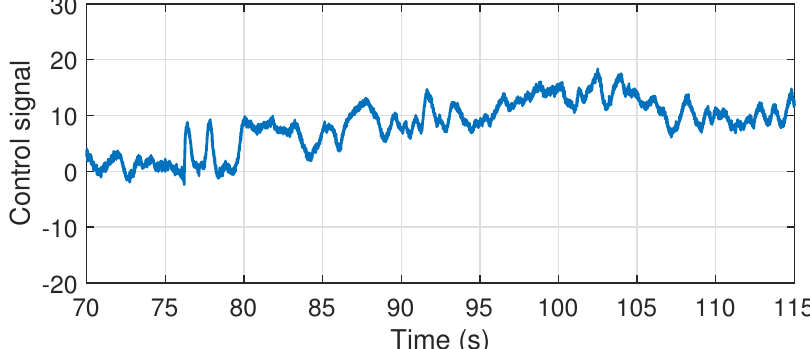
Figure 28. Control signal for yaw axis.